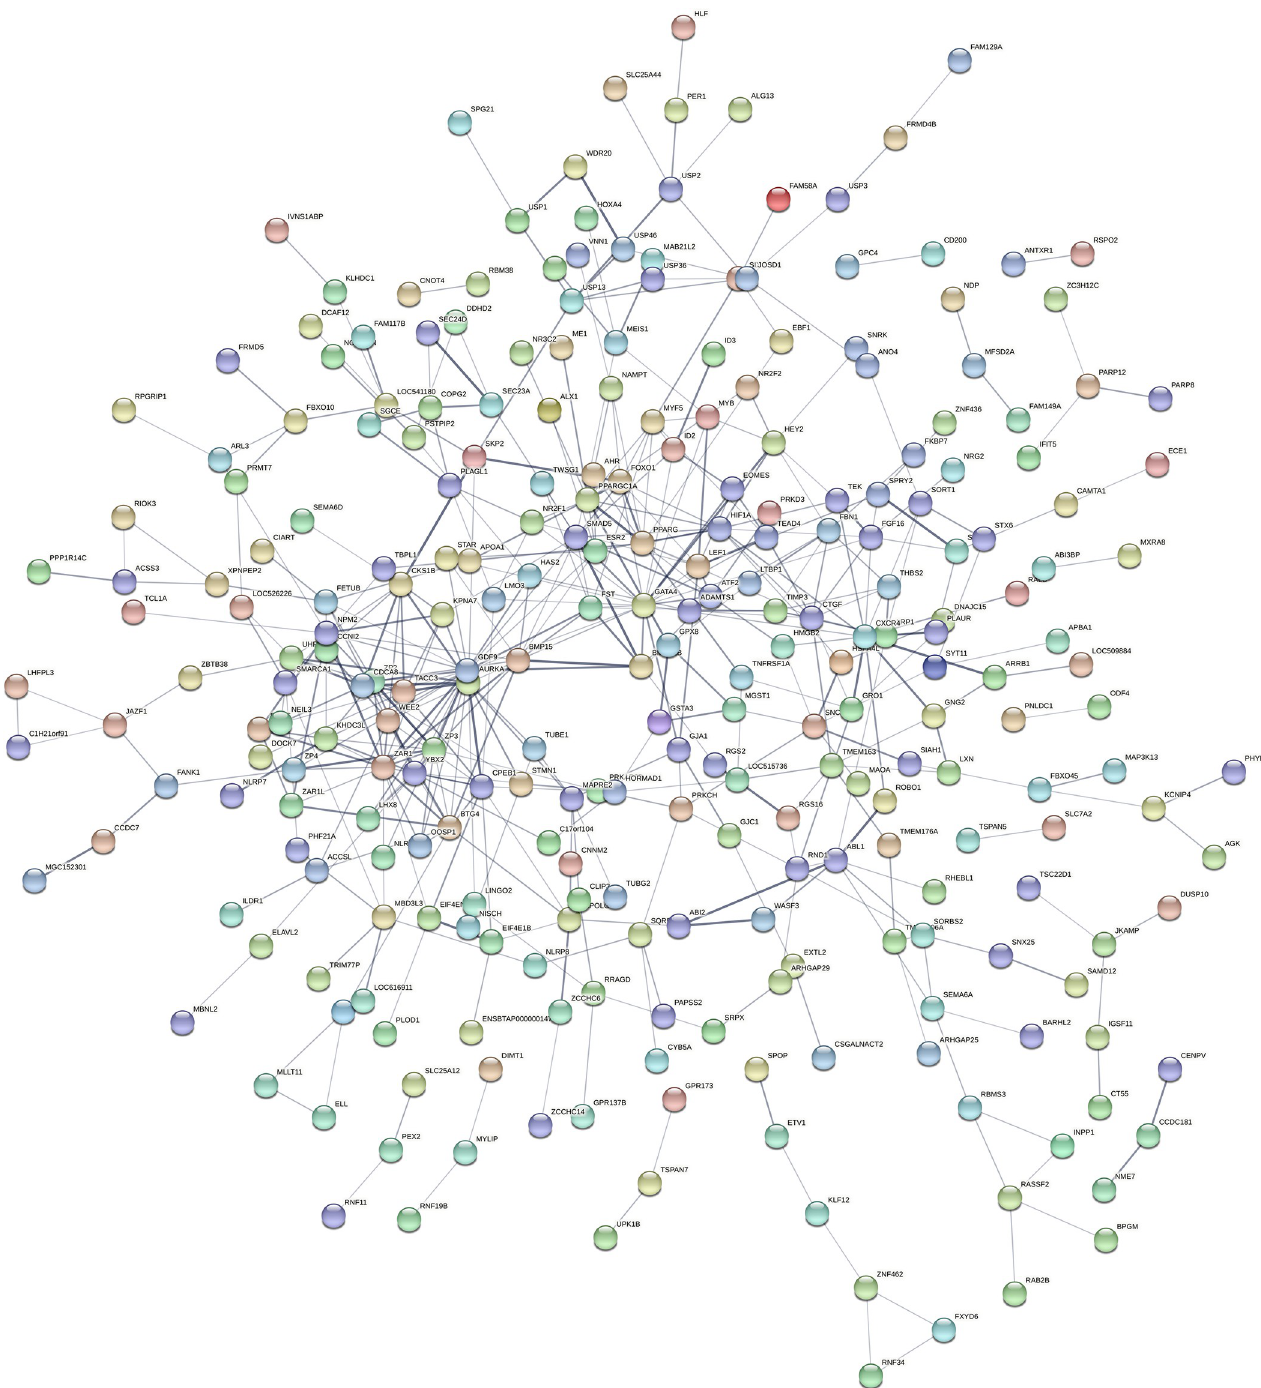
Fig 8. Possible protein–protein connections of overlapping differentially expressed genes. STRING analysis of the overlapping genes expressed differentially in blastocysts from synchronously and asynchronously vs. directly cleaved embryos. Only genes with nodes in the network association are presented. For a better view of the figure, it is highly recommended to use the magnifier tool.